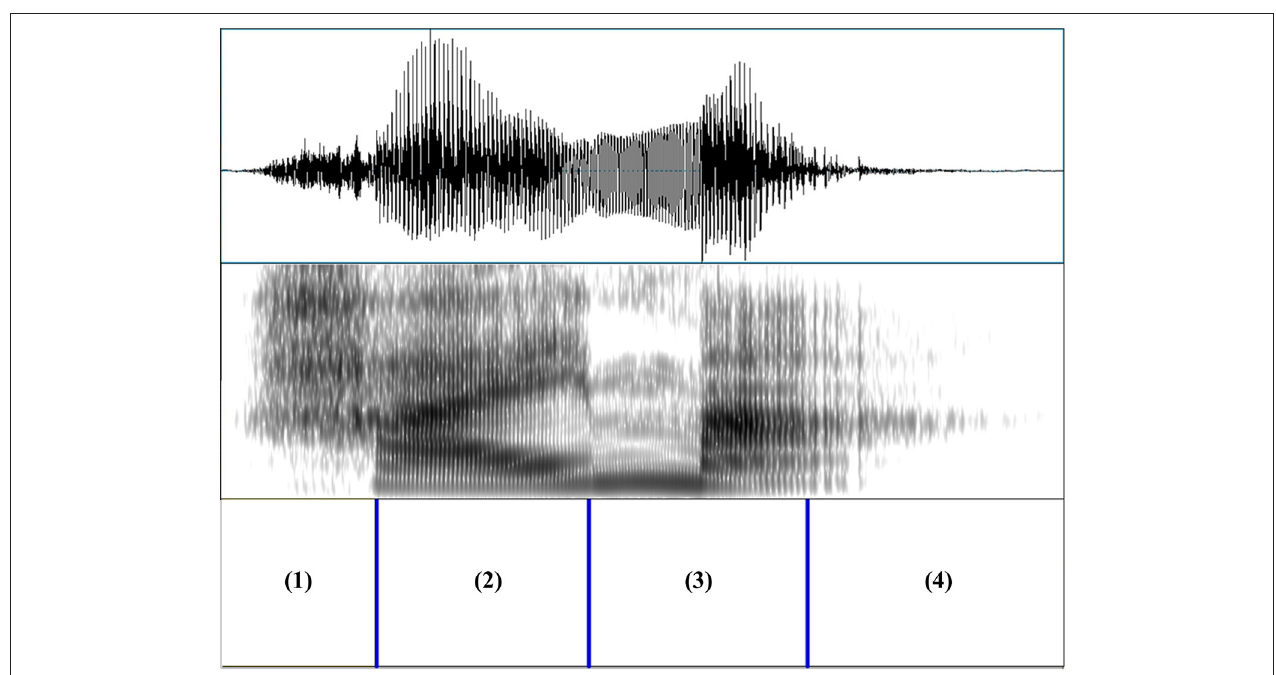
FIGURE 1 | Demarcation of one base token (example: 海 马 , /xai 3 ma 3 /, seahorse) before manipulation: (1) the initial fricative /x/ without vocal-fold vibration; (2) the voicing portion of the first syllable (S1); (3) the voicing portion of the second syllable (S2); (4) the end of S2 characterized by strong creaky voice, not amenable to F0 manipulation.